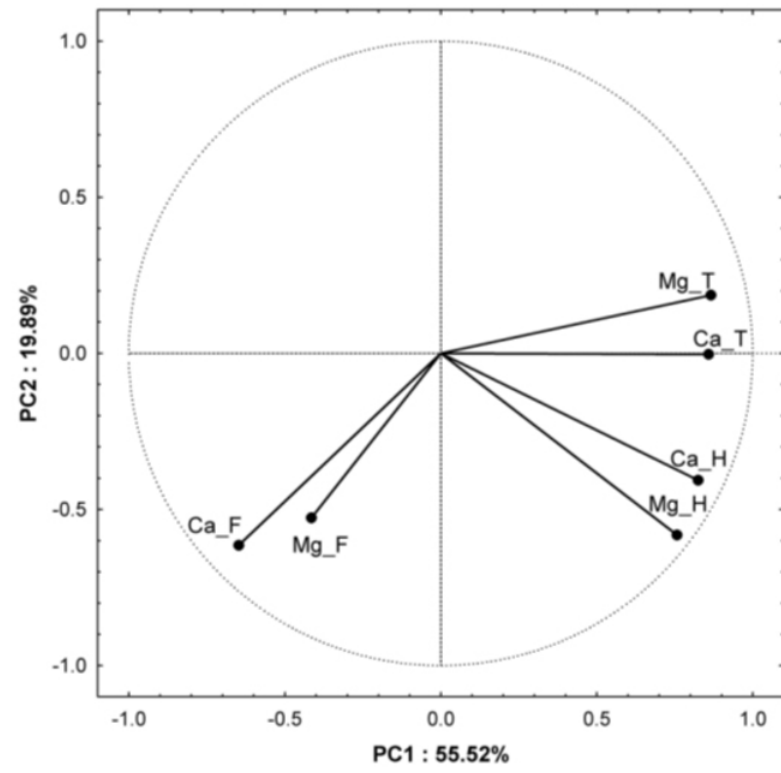
Figure 1. Projection of variables (Ca and Mg) on the plane of PC1 (55.52%) and PC2 (19.89%) principal components.